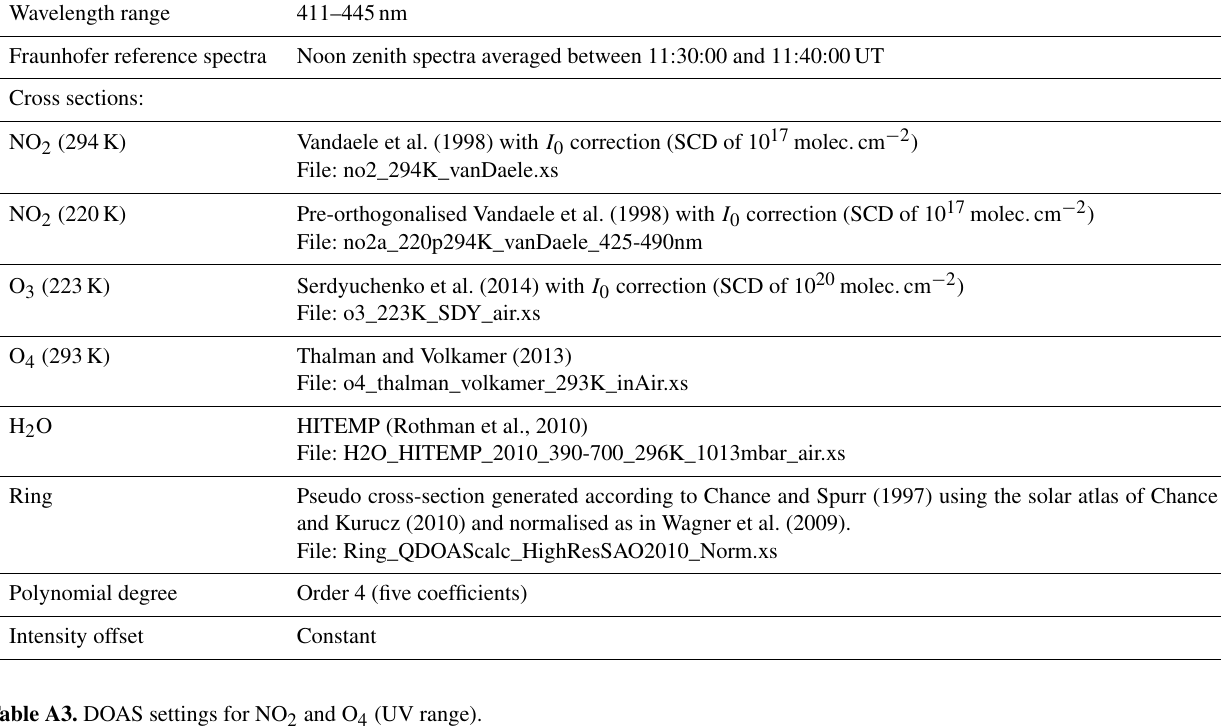
Table A2. DOAS settings for NO 2 and O 4 (alternative visible range). Wavelength range